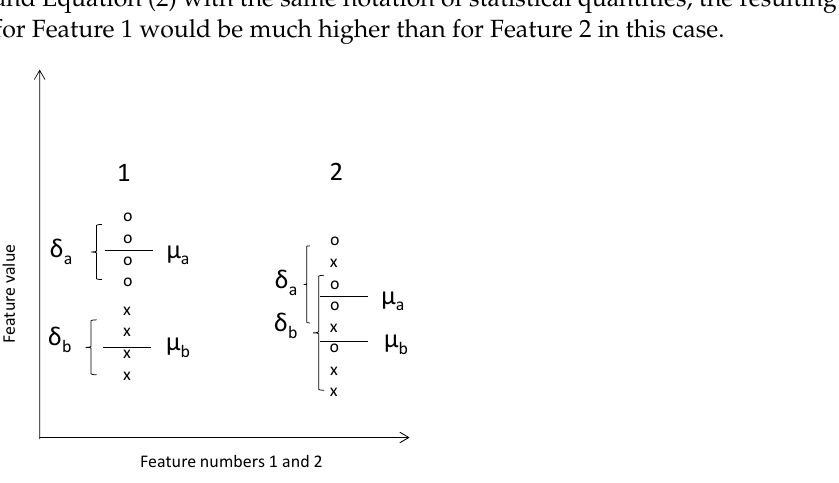
Figure 4. An illustrated example of the usage of D sn for identifying classification properties of features in the case of two data groups (o and x ). Classification between the data groups would be successful with Feature 1 in this case.